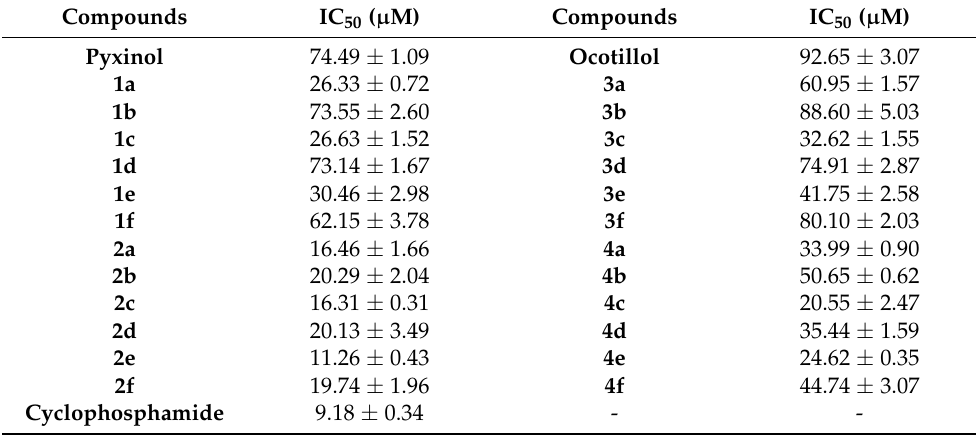
Table 1. IC 50 (µM) of all compounds over HepG2 cells. Table 1. IC 50 ( µ M) of all compounds over HepG2